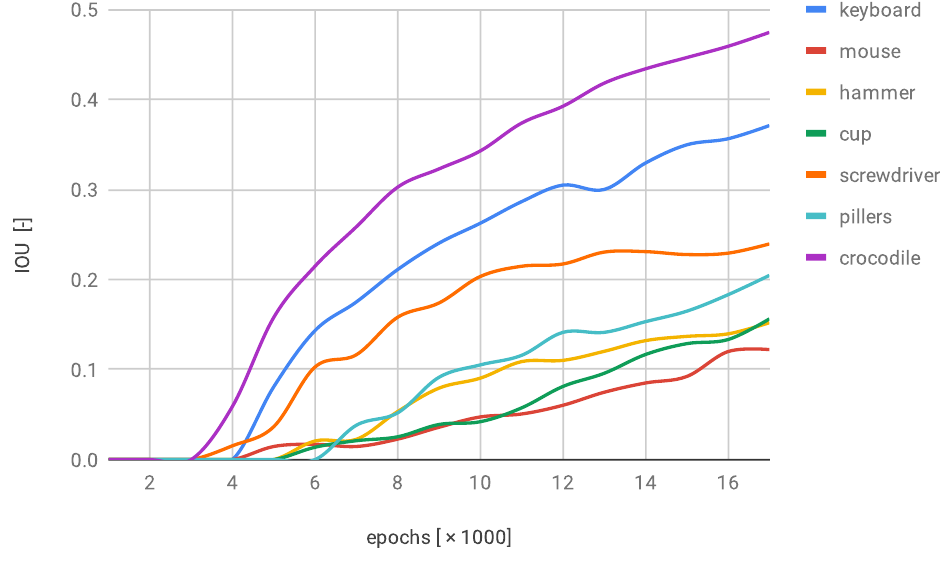
Figure 11. IOU changes over training progress on second modified